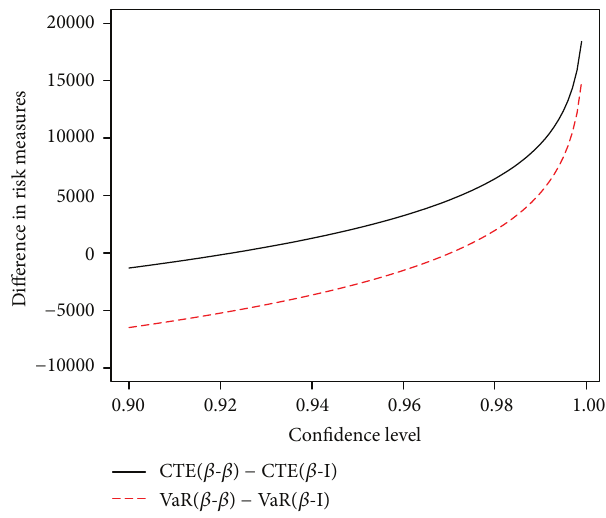
Figure 9: The differences between approximated risk measures, under the 𝛽 - 𝛽 model and the 𝛽 -I model, of 𝑆 𝑛 , 𝑛 = 10 6 , the number of delinquencies in a month for the Alt-A residential mortgage segment with (nominally) one million entities, at confidence levels, 0.9 ≤ 𝛼 ≤ 0.995